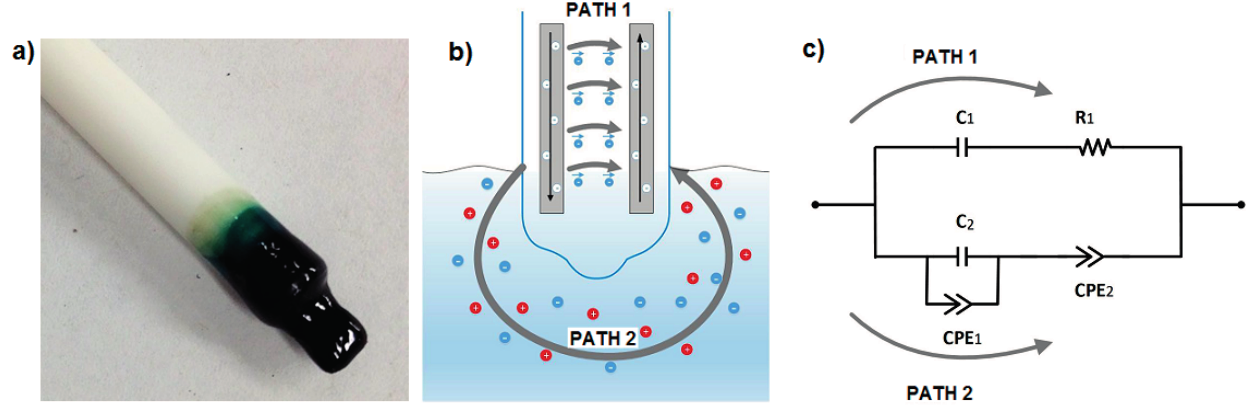
Figure 1. ( a ) Picture of the polyvinyl chloride-bis(2-ethylhexyl) phthalate